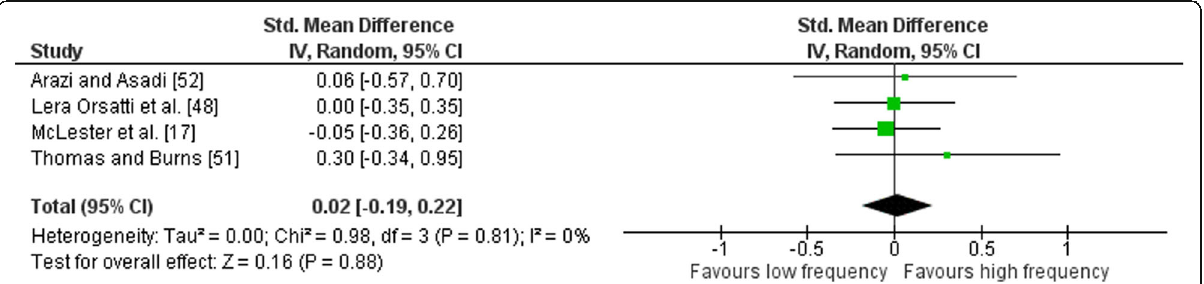
Fig. 7 Low vs. high weekly training frequency. Pre- vs. post-mean ES strength difference on multi-joint and isolation exercise. The vertical line indicates the overall estimate of combined multi-joint and isolation studies pre- vs. post-mean ES strength difference. Horizontal lines indicate 95% CI, squares estimates, whereas square size is proportional to sample size, and rhombs ’ meta-analytically pooled